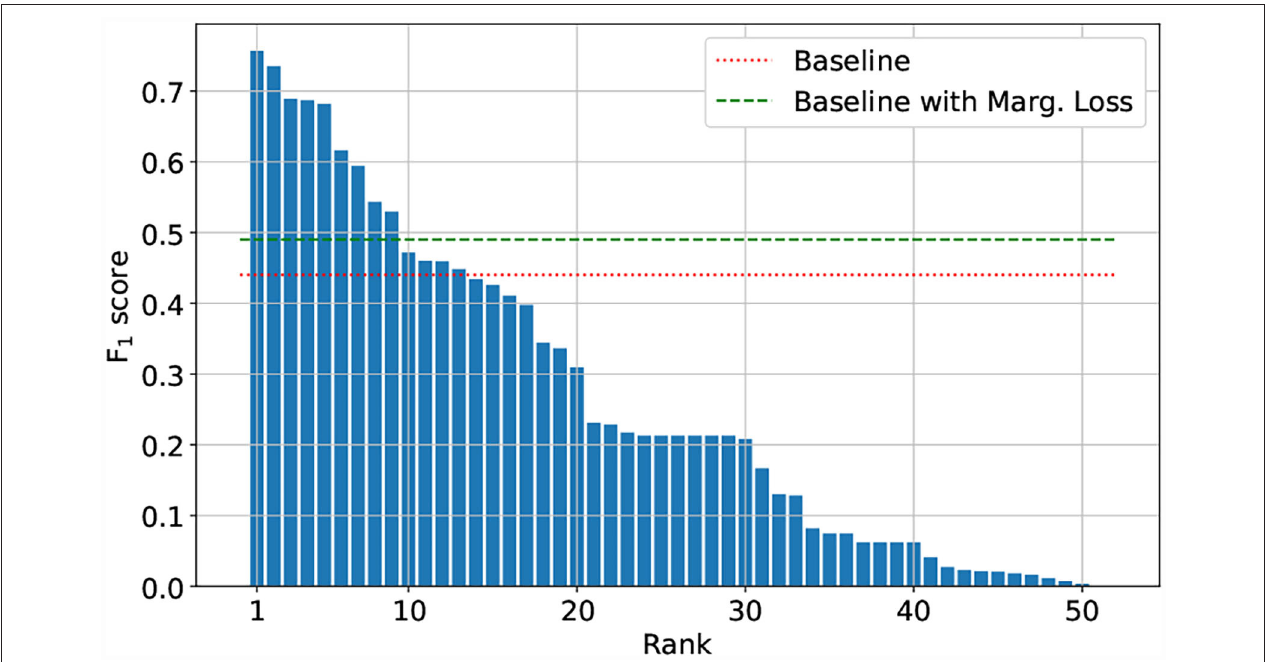
FIGURE 7 | F 1 scores of the 50 best performing